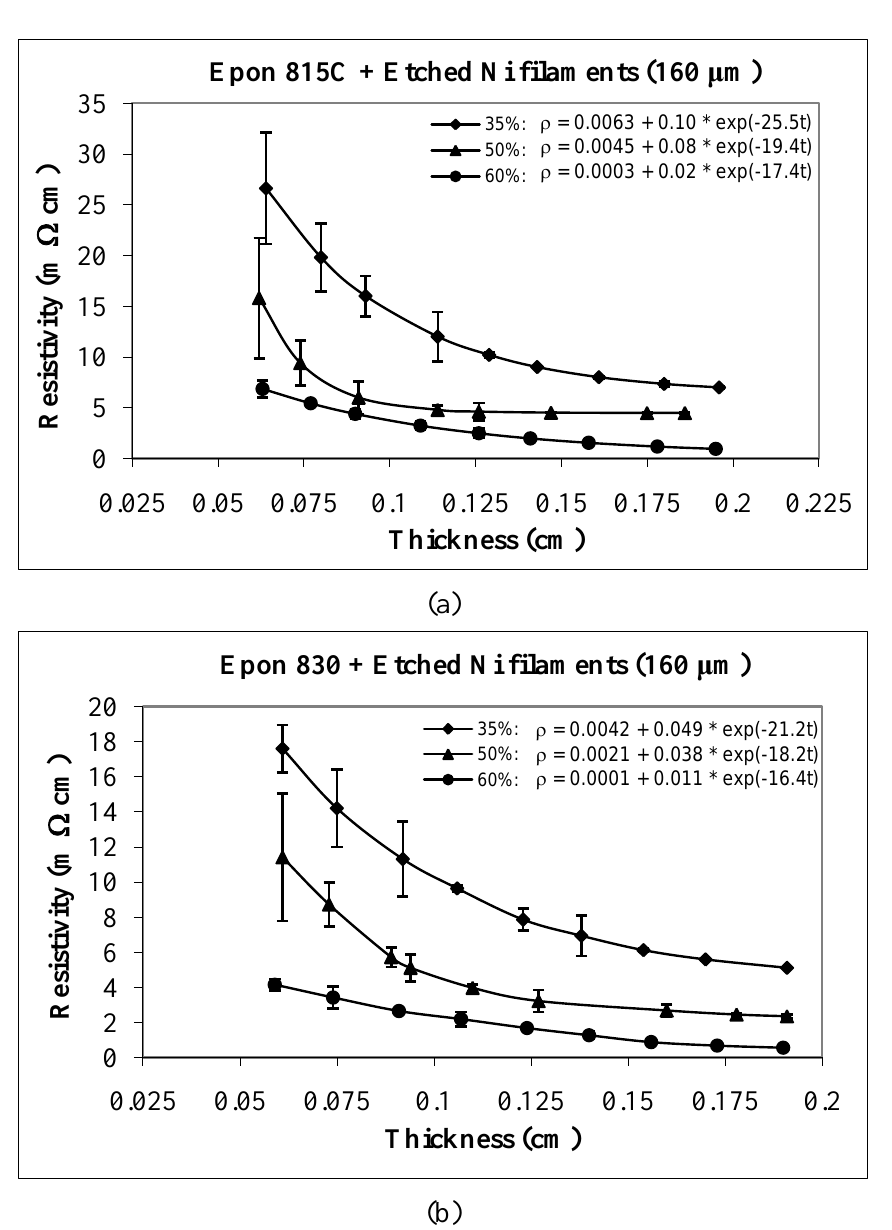
Figure 10. Thickness-dependent resistivity of Epon 815C ( a ), and 830 ( b ) films filled 35%, 50%, 60% by volume with etched nickel filaments (160 